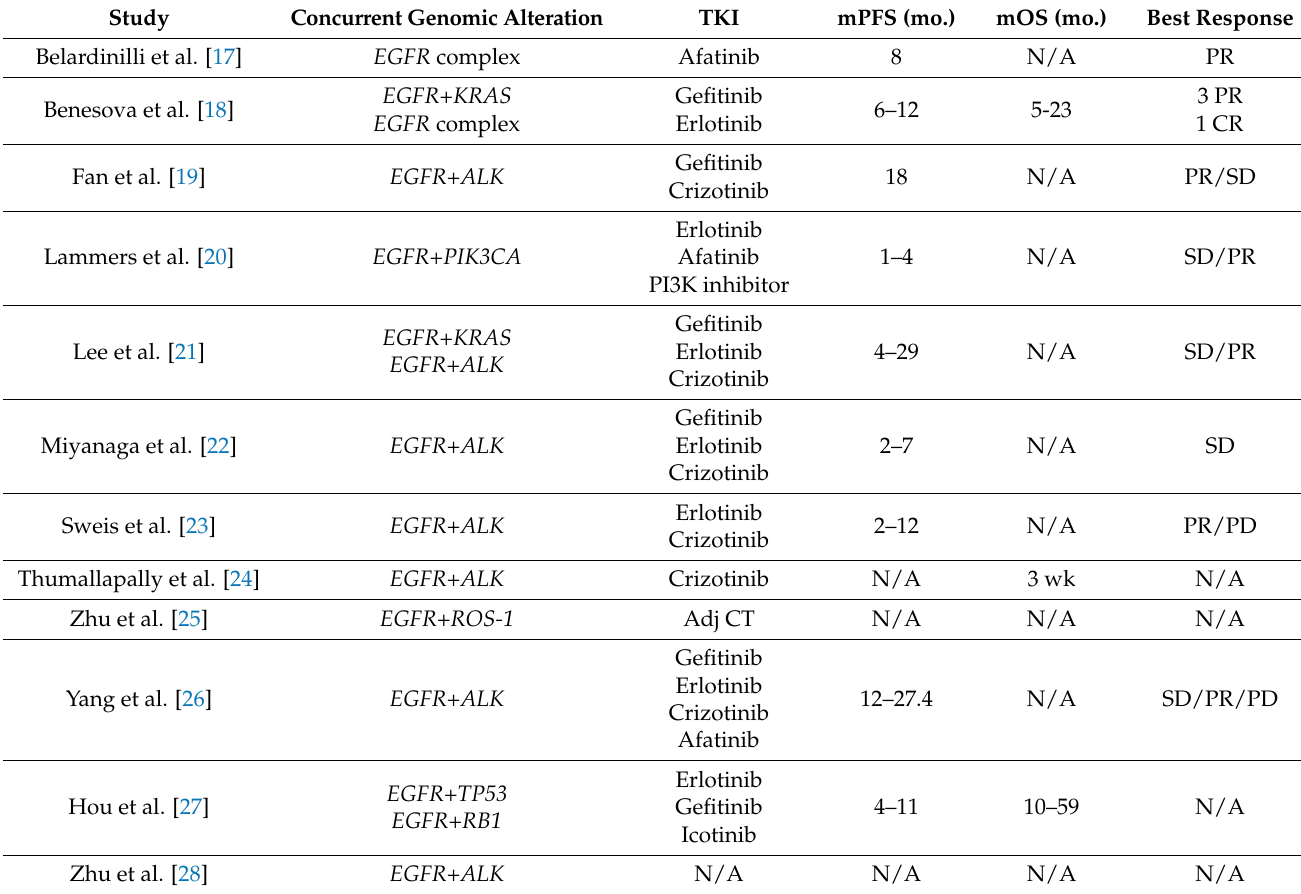
Figure 2. Distribution of the different concurrent EGFR mutations pathways. Table 2. Summary of reported treatment outcomes of NSCLC patients with double concurrent genetic